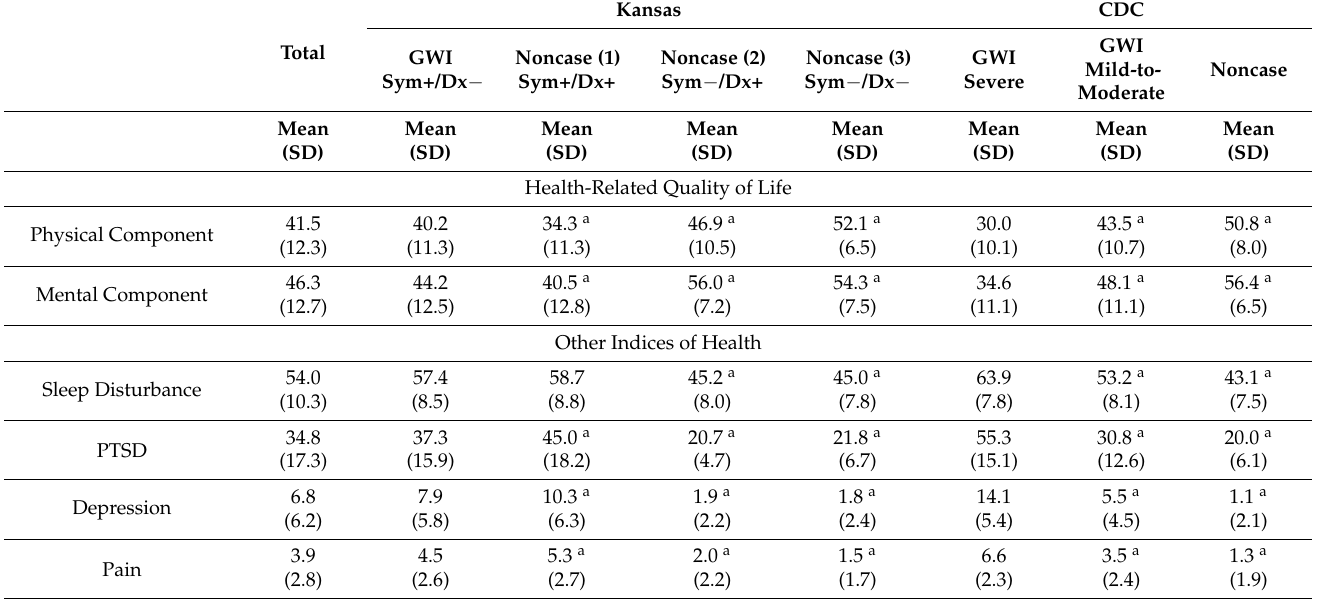
Table 2. Descriptive Statistics: Veterans RAND-12, Sleep Disturbance, Post-Traumatic Stress, Depres- sion, and Pain by GWI Case Status (unadjusted